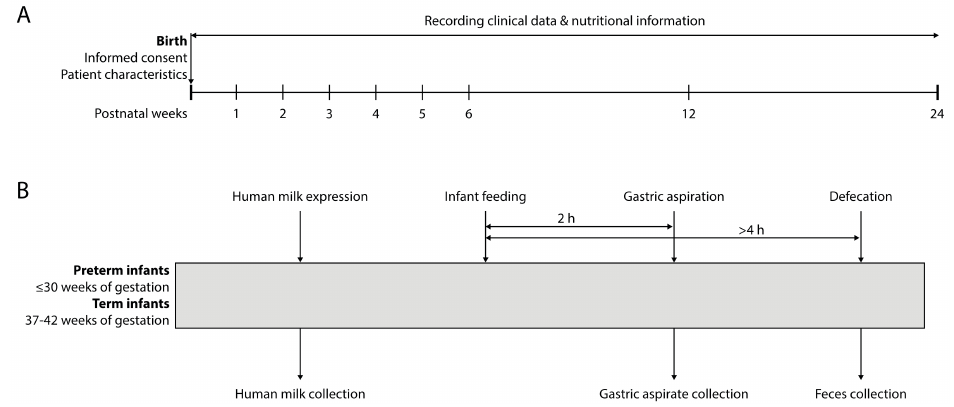
Figure 1. Sampling and data collection scheme. Scheme of ( A ) sampling points over the first six months and ( B ) one sampling point. While human milk and feces will be collected in full-term and preterm infants, gastric aspirates will only be collected in preterm infants during hospital stay. Clinical data will be monitored at every sampling point throughout the duration of the